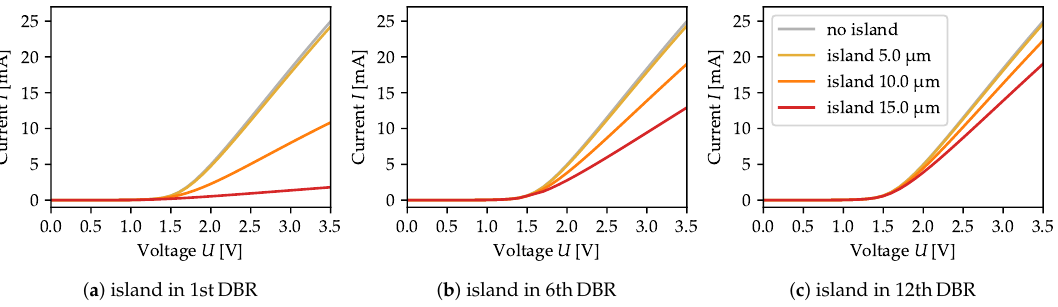
Figure 4. I-V curves for islands located in the 1st, 6th, and 12th DBR pairs for three different oxide island diameters. The impact of the island on structure resistivity is significant if it is close to the cavity and decreases with increasing distance.